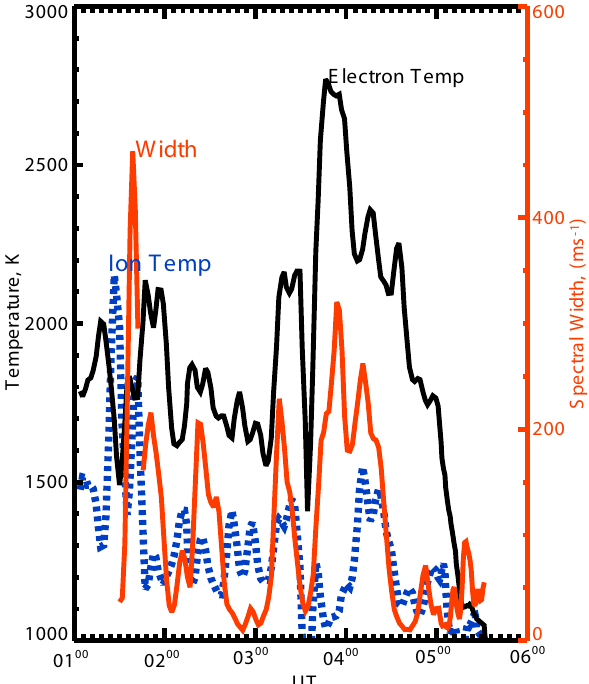
Fig. 4. Line plots from collocated radar cells of EISCAT beam 1 and beam 9 of CUTLASS Finland, within the 71 ◦ N to 72 ◦ N (AACGM) latitude range. Electron temperature is in black, ion temperature in blue (dotted) and spectral width is in